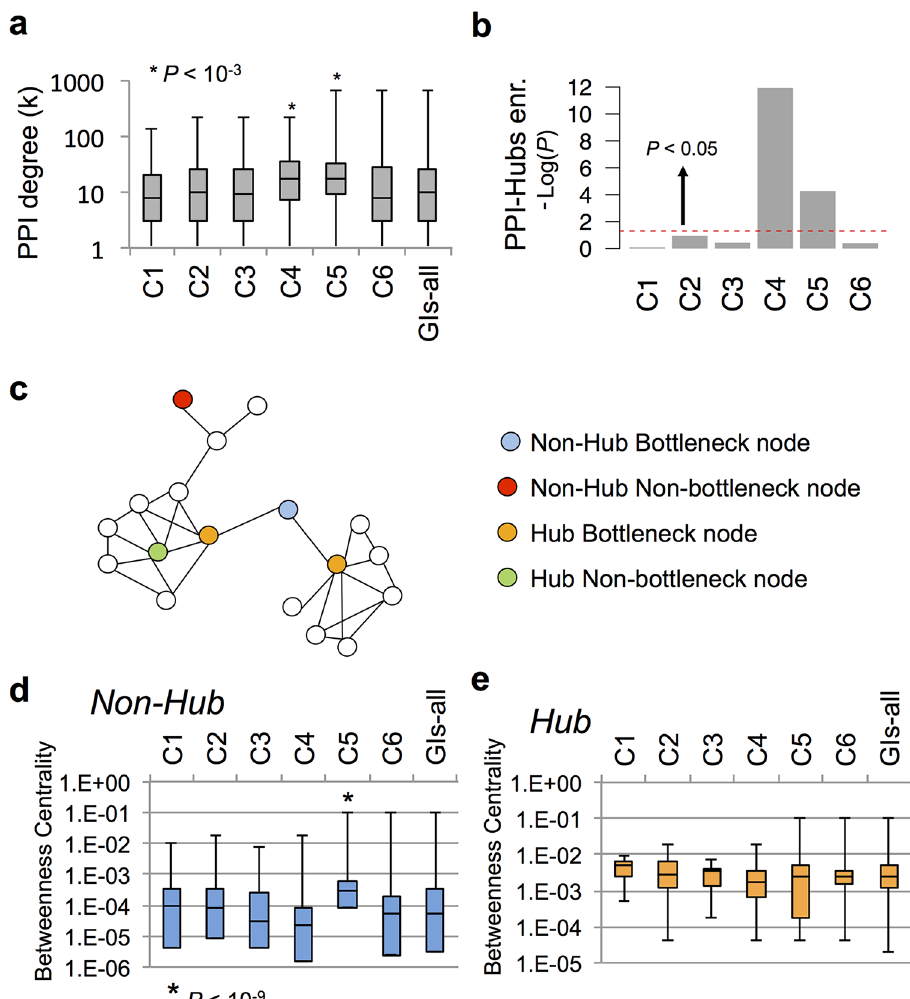
Fig 3. GI classes have different position in PPI-network. (a) Physical interaction degree of gene products in the protein-protein interaction (PPI) network (only genes coding for proteins with at least one interacting partner were considered). * P < 10 − 3 , Wilcoxon rank-sum test, indicates significant difference when compared to GIs-all and other GI classes. (b) Enrichment of PPI-Hubs in GI classes when compared to GIs-all. -Log 10 of P-values obtained using Fisher ’ s tests are indicated. The area over the red dashed line indicates significant enrichment ( P < 0.05). (c) Illustration of bottlenecks and the different type of nodes in the protein-protein interaction (PPI) network (adapted from [36]). (d-e) Betweenness centrality of non-Hub and Hub gene products. * P < 10 − 3 , Wilcoxon rank-sum test, indicates significant difference when compared to other GI classes. The box plots (a, d-e) represent the min, max, 25 th , 50 th (median) and 75 th percentile of either PPI Degree (k) or betweenness centrality